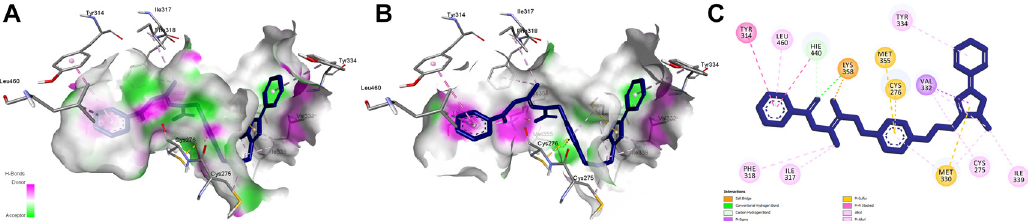
Figure 4: Illustration of polymorphic PPARA interaction with ligand at lowest binding energy. (A) Surface illustration of ligand receptor interaction, (B) reverse slide illustration, (C) diagram illustration of ligand receptor